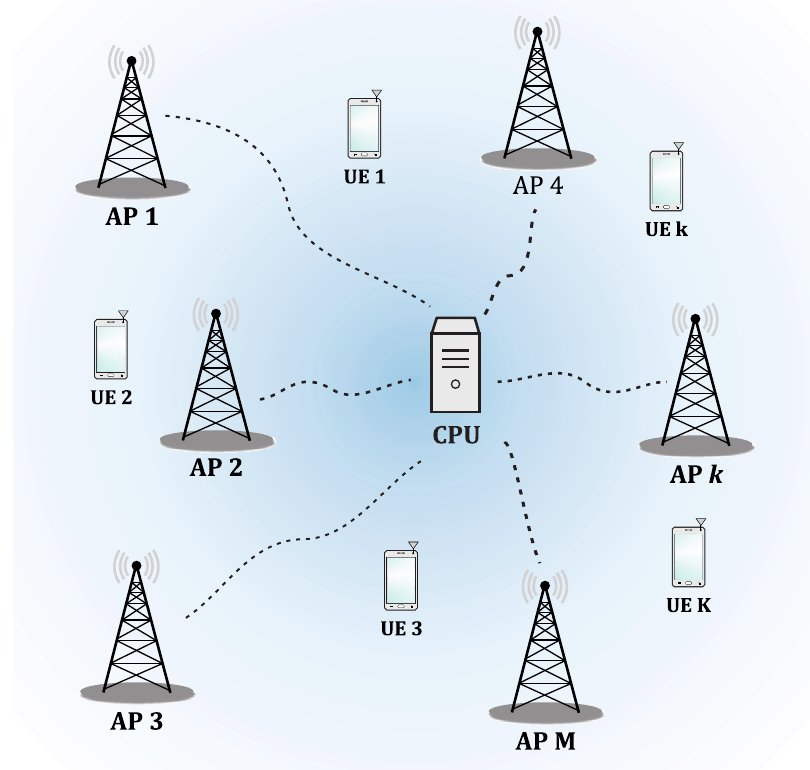
Figure 3. Cell-free